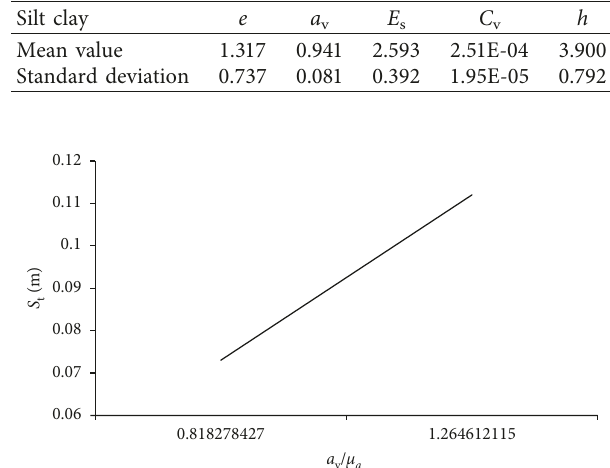
Figure 3: Effect of compression coefficient on final consolidation settlement.